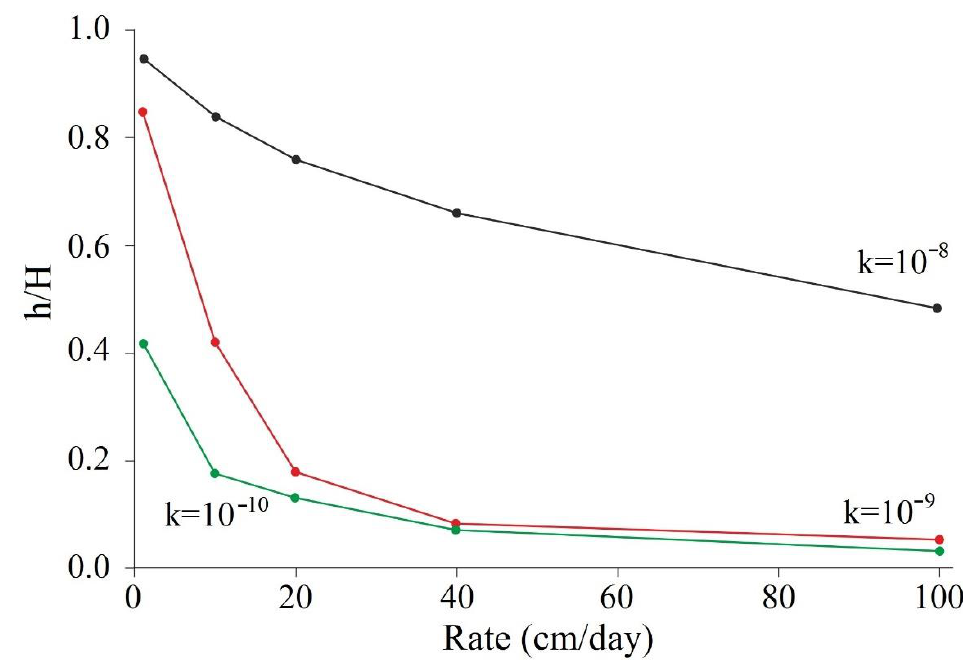
Figure 4. Dependency of a drawdown on the discharge rate with different permeability coefficients.